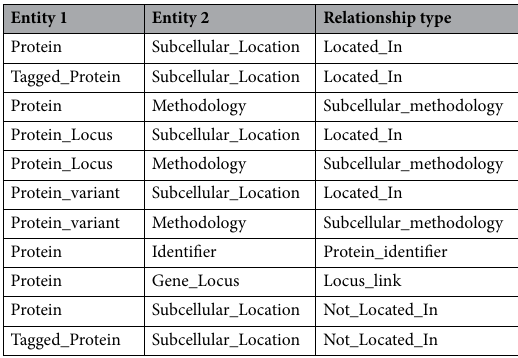
Table 2. BRAT annotation entity and relationship types defined for the SUBA and CropPAL